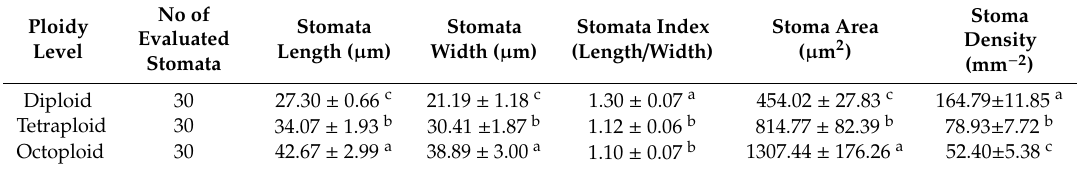
Table 5. Content of leaf pigments in diploid, tetraploid, and octoploid R.